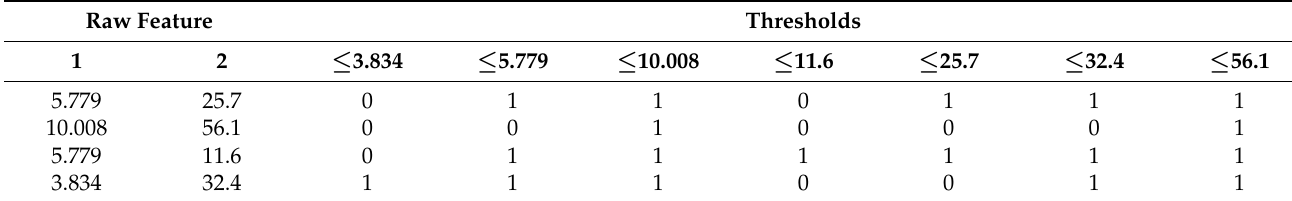
Table 2. Preprocessing of two continuous